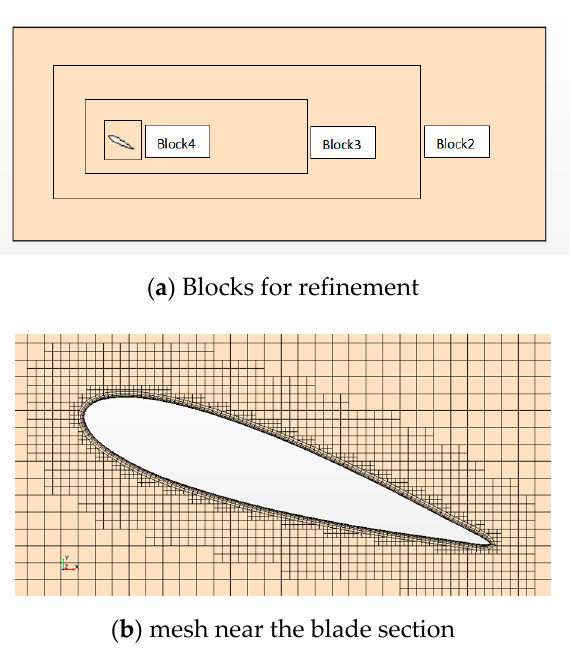
Figure 5. Illustration of computational mesh for ( a ) blocks used for mesh refinement and ( b ) local mesh near the blade section. Table 2. Mesh independence